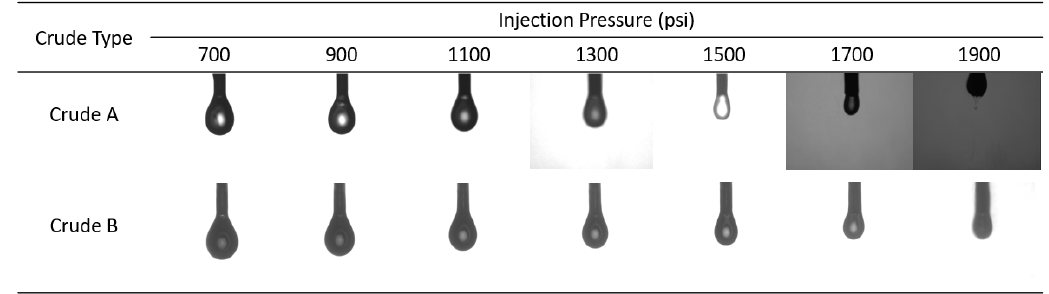
◦ C. Processes 2020 , 8 , x FOR PEER REVIEW